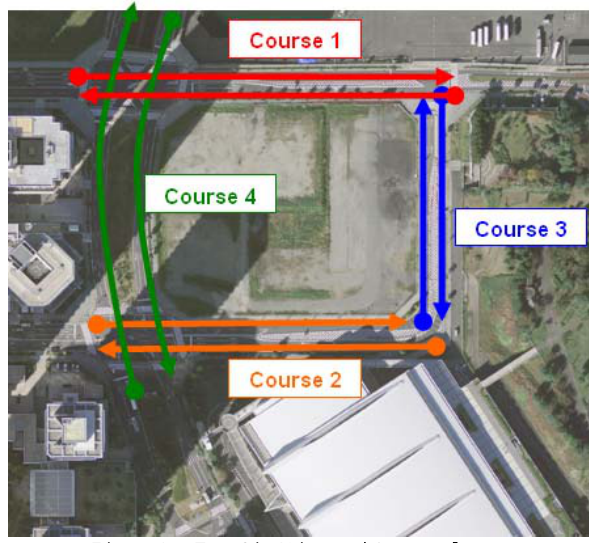
Figure 4. Test Site View and Courses layout